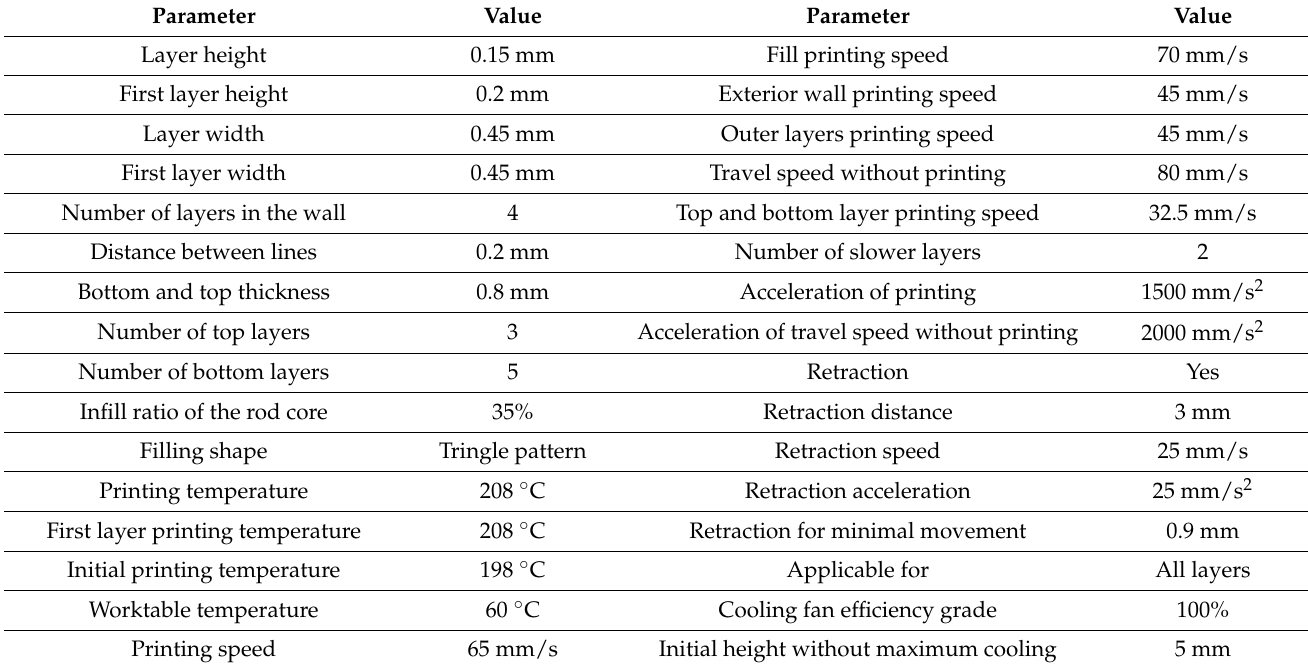
Table 3. Printing